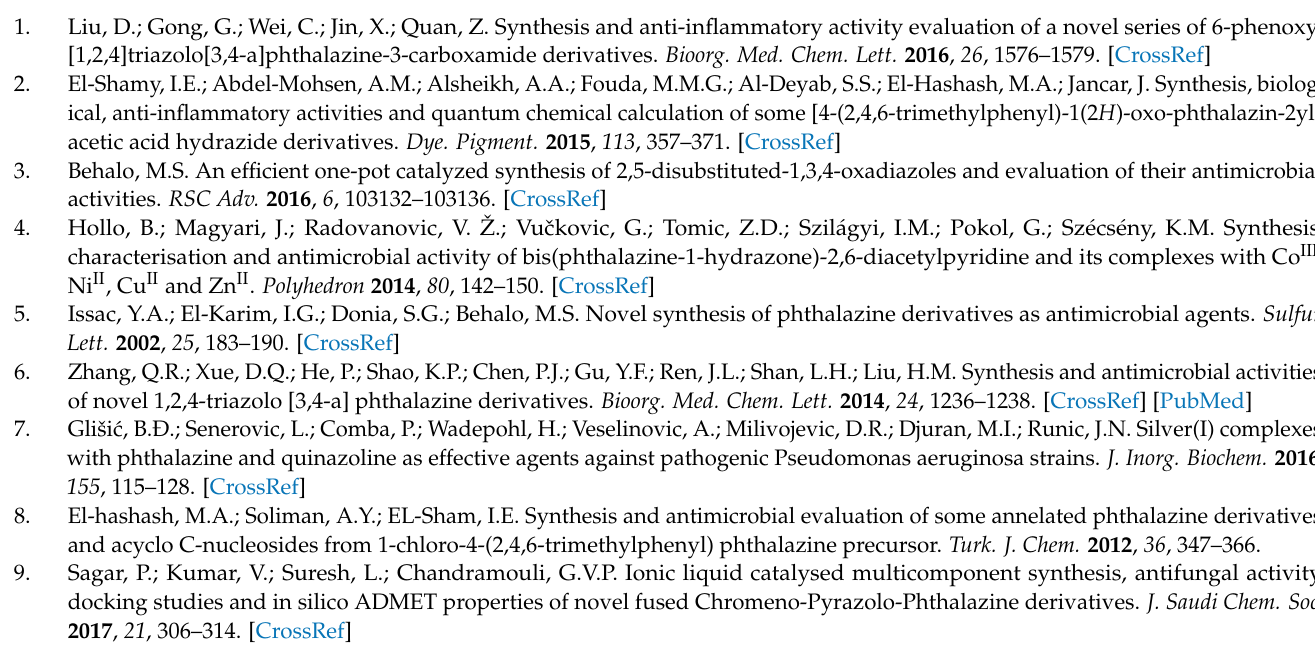
Figure S3: 1 H-NMR spectra of HL OH ; Figure S4: 13 C-NMR spectra of HL OH ; Figure S5: FTIR spectra of [Cd(H 2 L)Cl 3 ] n *H 2 O; 1 ; Figure S6: FTIR spectra of [Cd(TPT)(SCN) 2 ] n *H 2 O; 2 ; Figure S7: